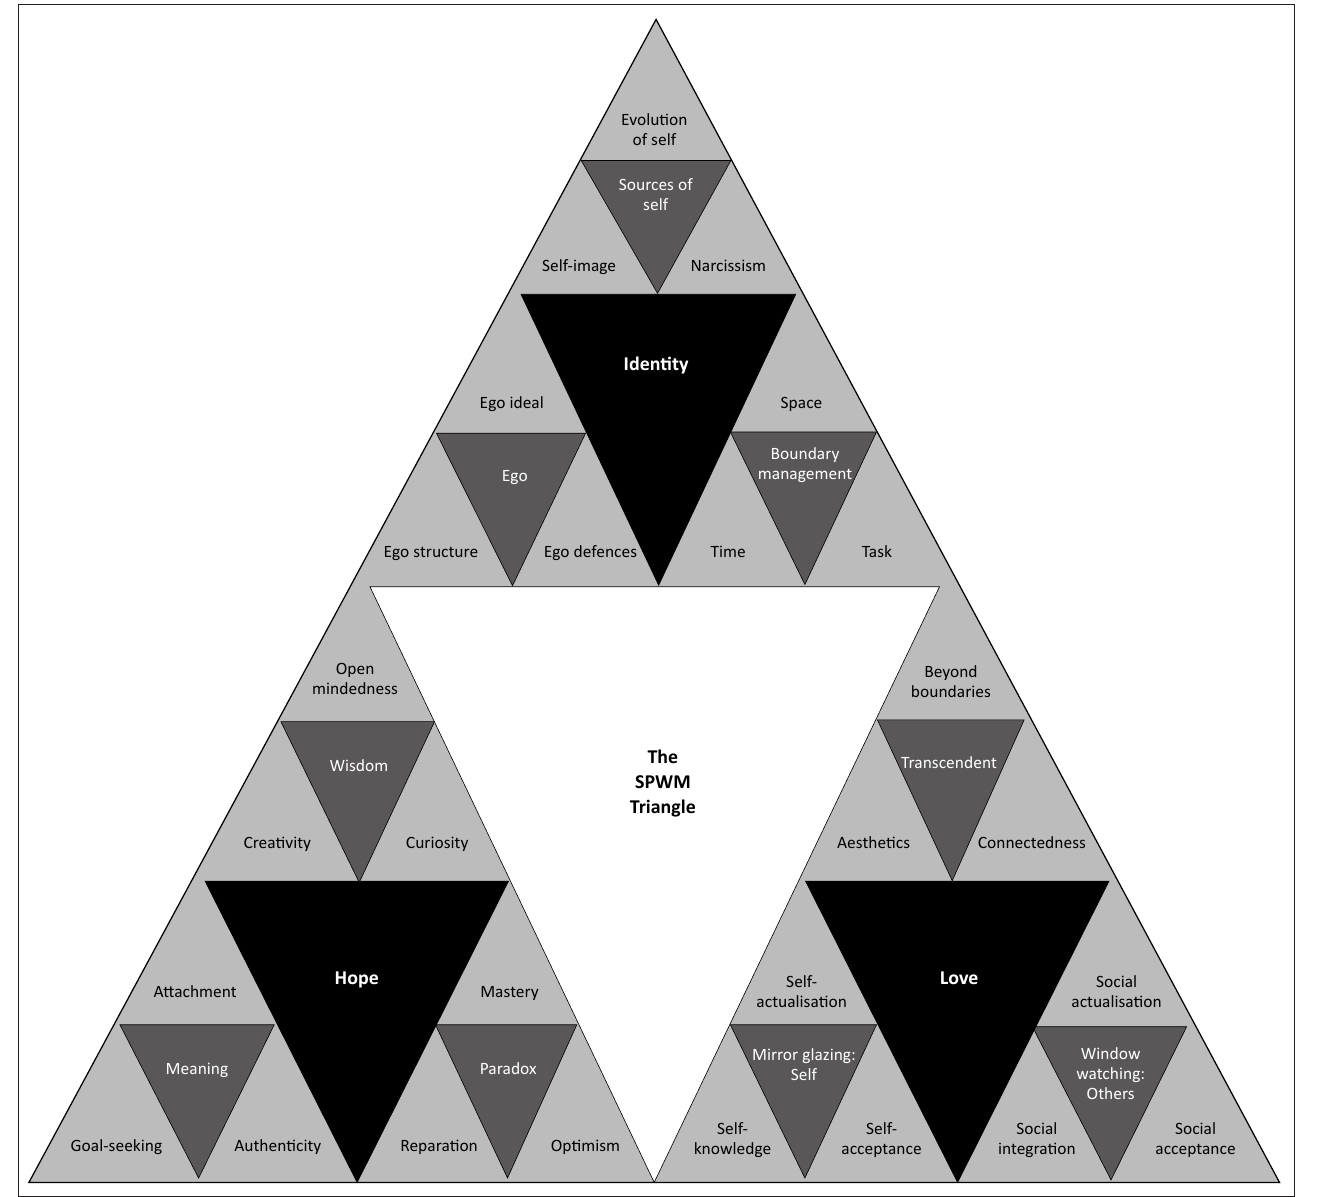
FIGURE 3: The Systems Psychodynamic Wellness